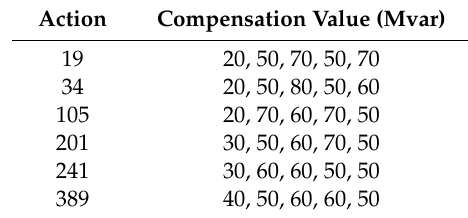
Table 7. Compensation Values.